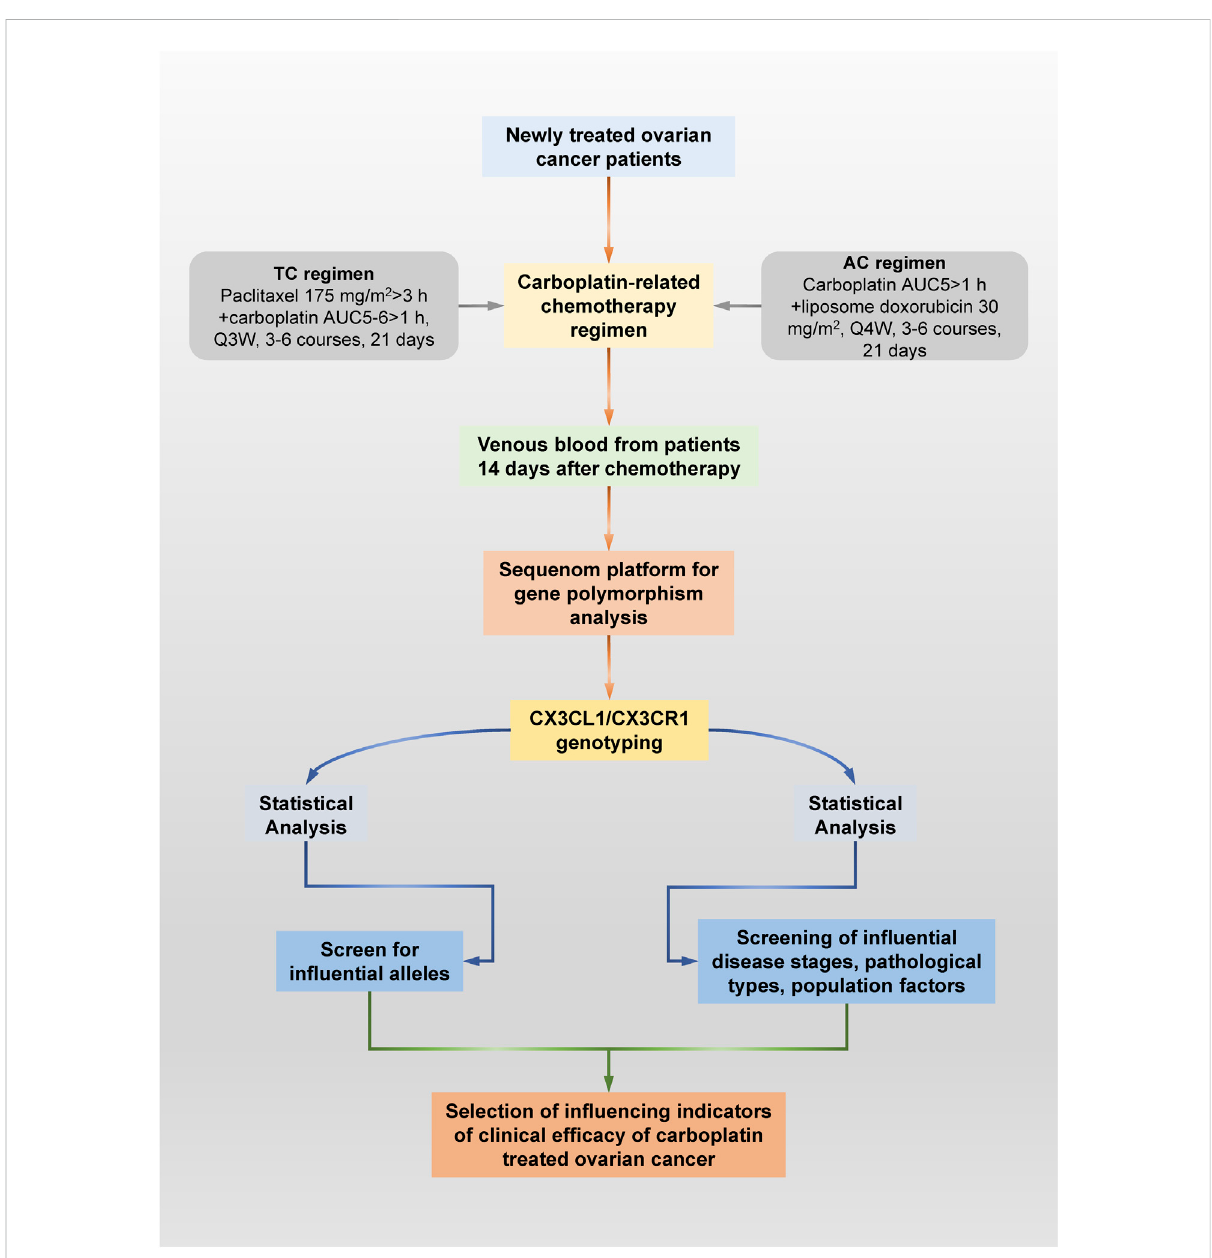
FIGURE 1 Speci fi cresearchprocessschematicdiagram.Thisstudyexploredovariancancerpatientswhoreceivedcarboplatinanditsrelateddrugsforthe fi rst time through pharmacogenomics technology based on Sequenom Mass ARRAY technology. Valuable ovarian cancer patients were screened according to a series of strict inclusion and exclusion criteria. Blood remaining after clinical testing was collected from all patients for genetic polymorphism testing. At thesame time,thepathologicaltype,disease stage, liverandkidney functionand groupindicatorsofall patients were obtained through the hospital information system. Finally, the signi fi cant speci fi c CX3CL1/CX3CR1 SNPs and other factors that affect the chemotherapy effect of carboplatin and related drugs were screened out through statistical